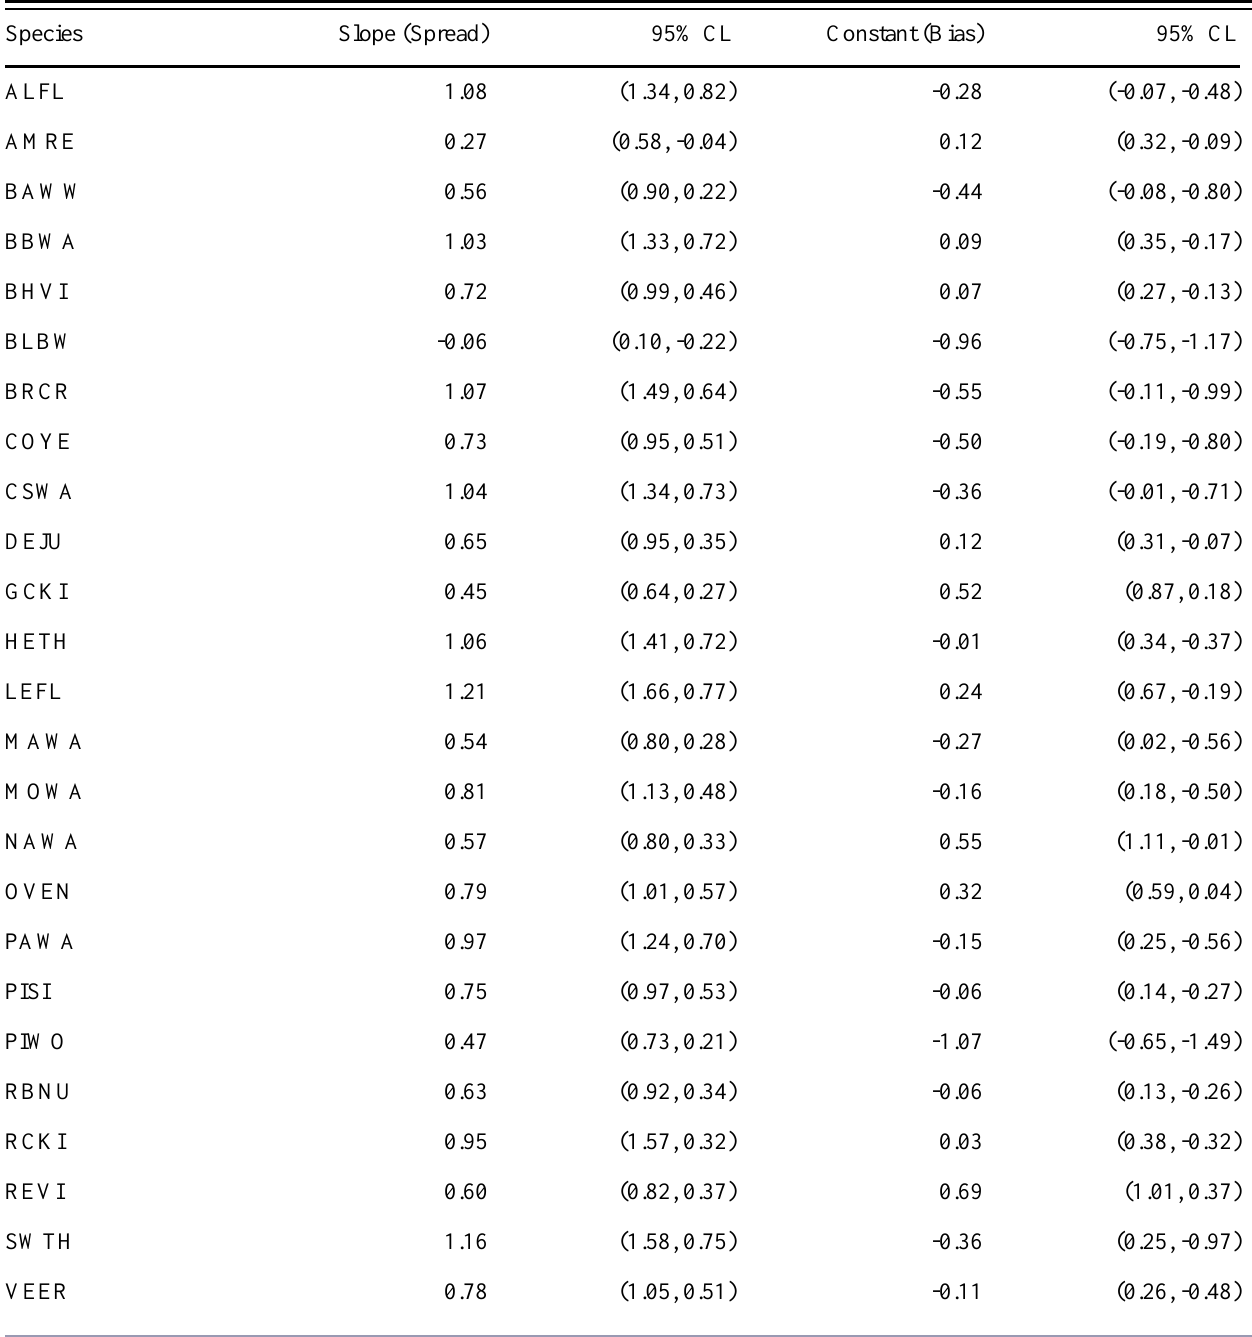
Table 6. Model reliability estimates, based on logistic-regression calibration curves of (logit) predicted probability vs. presence/absence in validation test site. Well-calibrated models have a slope approaching 1, and constant approaching